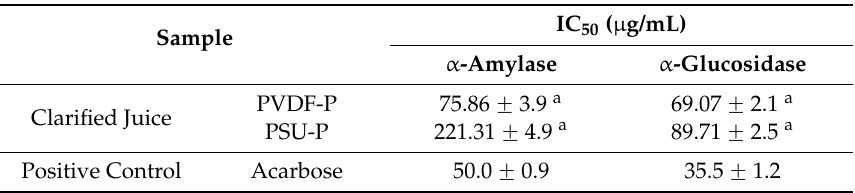
Table 5. Inhibitory α -amylase and α -glucosidase activity by samples of pomegranate juice clarified by PVDF and PSU